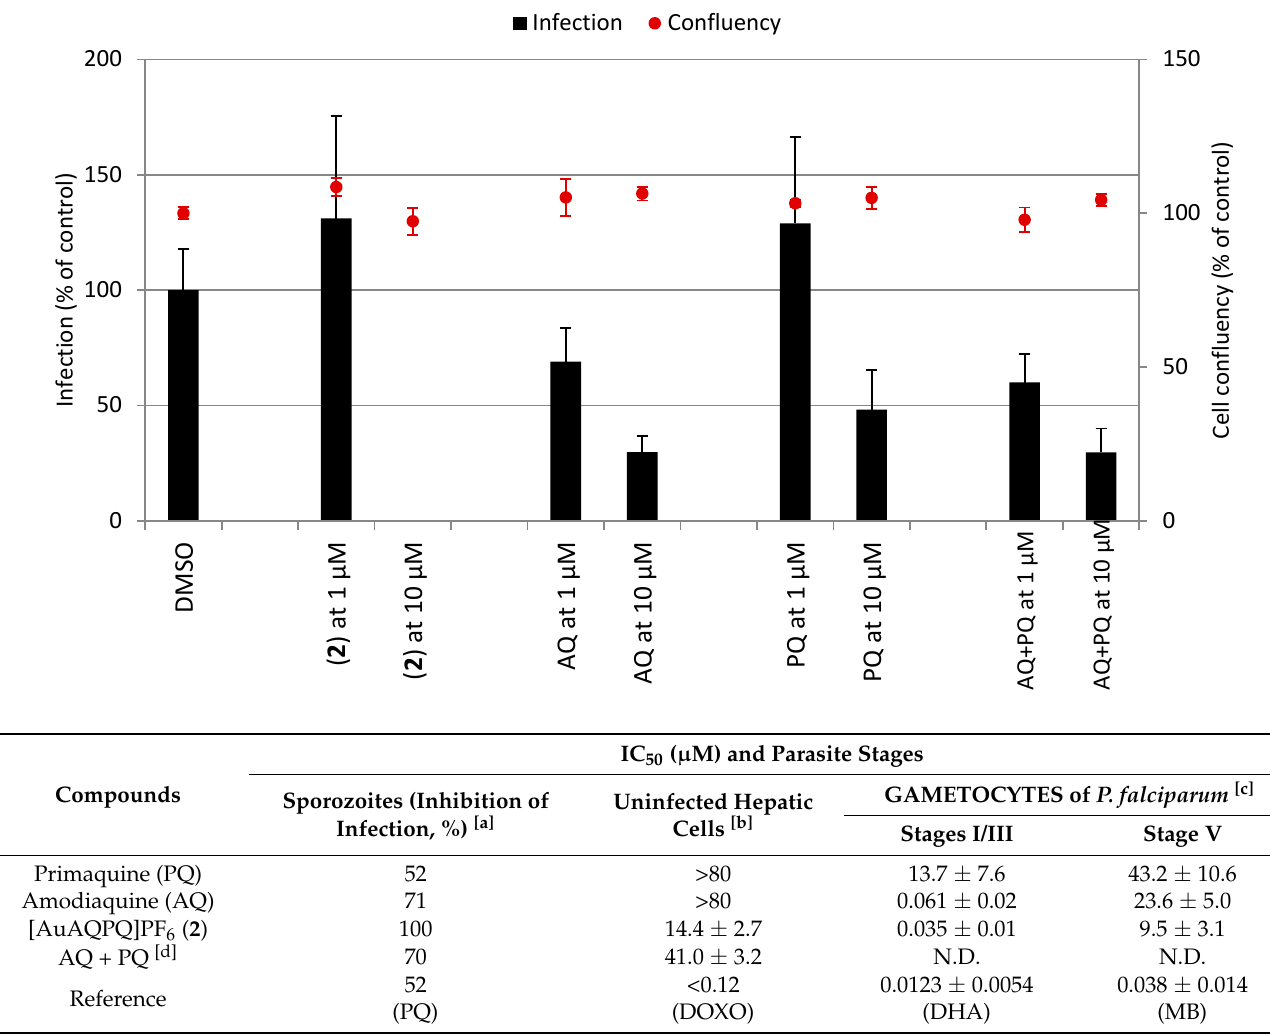
Table 2. In vitro activity of compounds against multiple stages of Plasmodium life cycle. Inset shows the infection of Huh-7 cells by P. berghei sporozoites (black bars) and the Huh-7 cell confluency (red